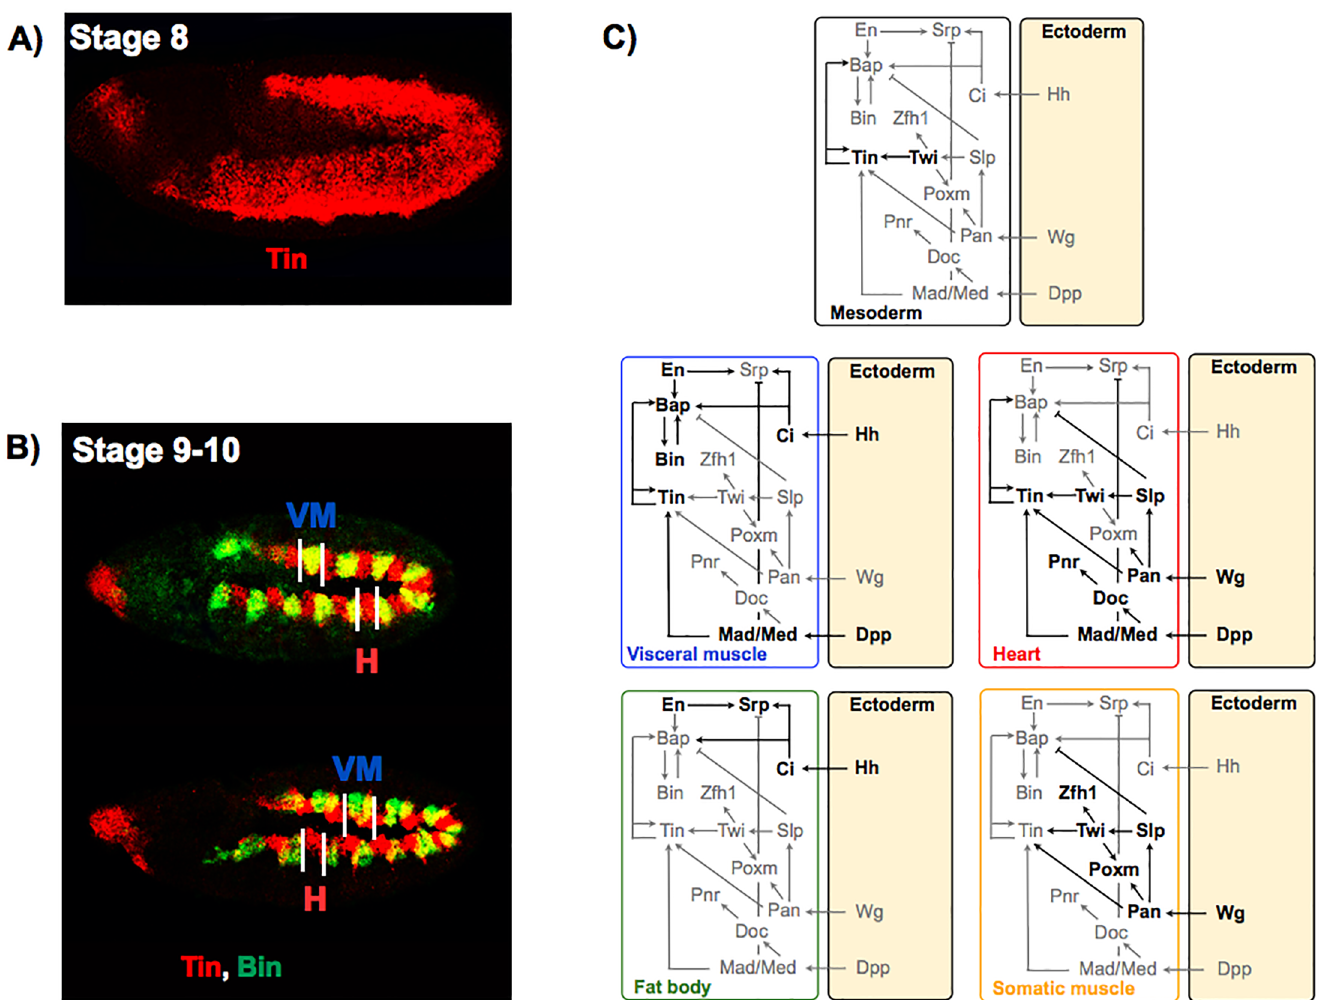
Fig 2. Key signalling pathways and markers genes involved in mesoderm specification. A, B: In situ hybridizations for Tin and Bin during mesoderm specification at stages 8 and 9 – 10. Tin is implicated in the formation of VM and H, while Bin participates only in the development of VM. Initially, the expression of Tin is mainly due to Twist activation. Later, Tin expression needs the presence of Dpp, Tin itself, in combination with Pan. C: Graphical representations of the main pathways activated by signals coming from the ectoderm, encompassing target transcription factors and cross- regulations underlying the specification of VM, H, FB and SM. In the absence of these factors, these tissues do not form or are severely reduced. Black and light grey arcs denote active and inactive regulations, depending on stage or tissue. Normal and blunt end arrows denote activations and inhibitions,